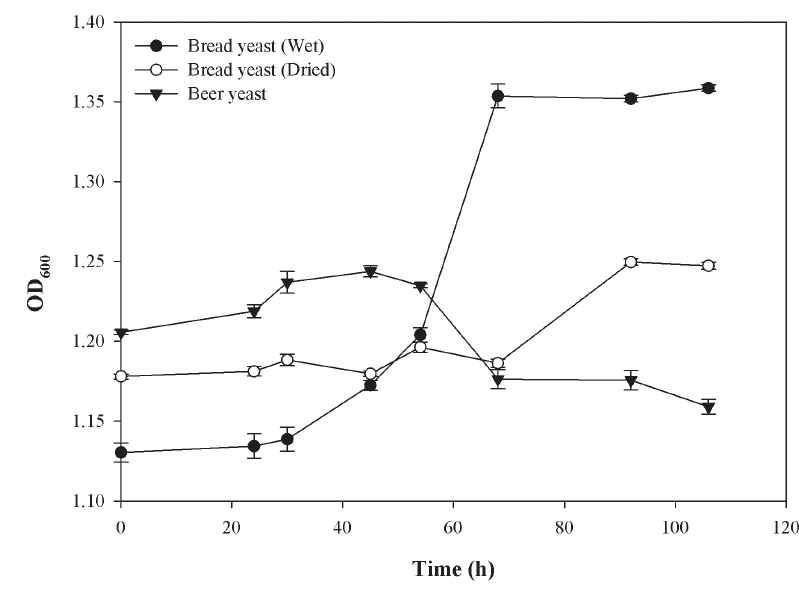
Fig. 1 – OD values of different yeast 600